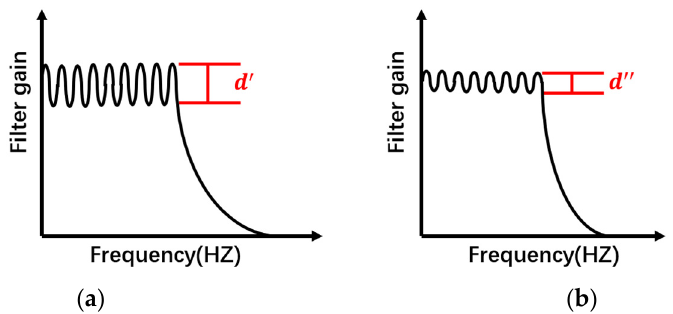
Figure 15. Characteristic curves of low-pass filter circuits with different design parameters: ( a ) Large passband ripple, ( b ) Small passband ripple.